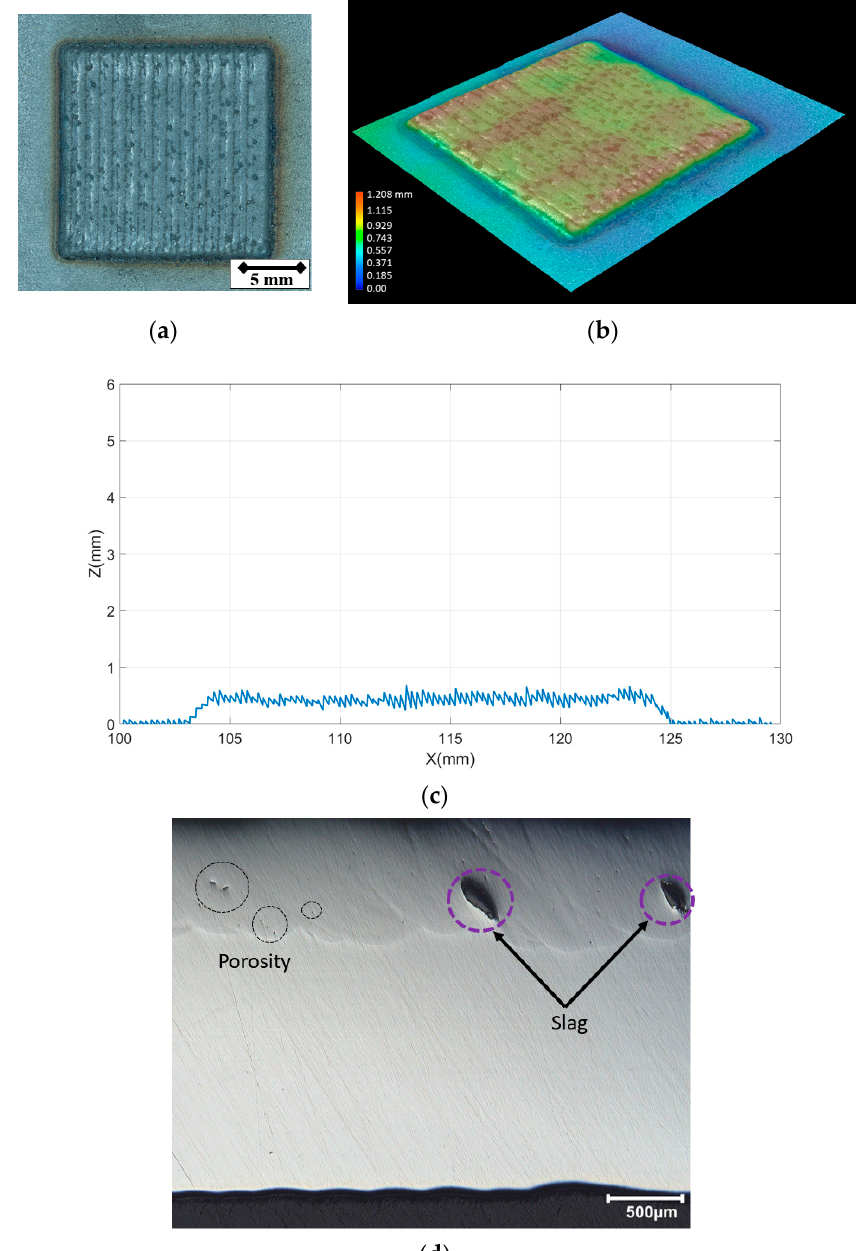
Figure 12. Multi-track clad layer: ( a ) photographic view, ( b ) 3D map, ( c ) geometry profile, ( d ) cross-section.